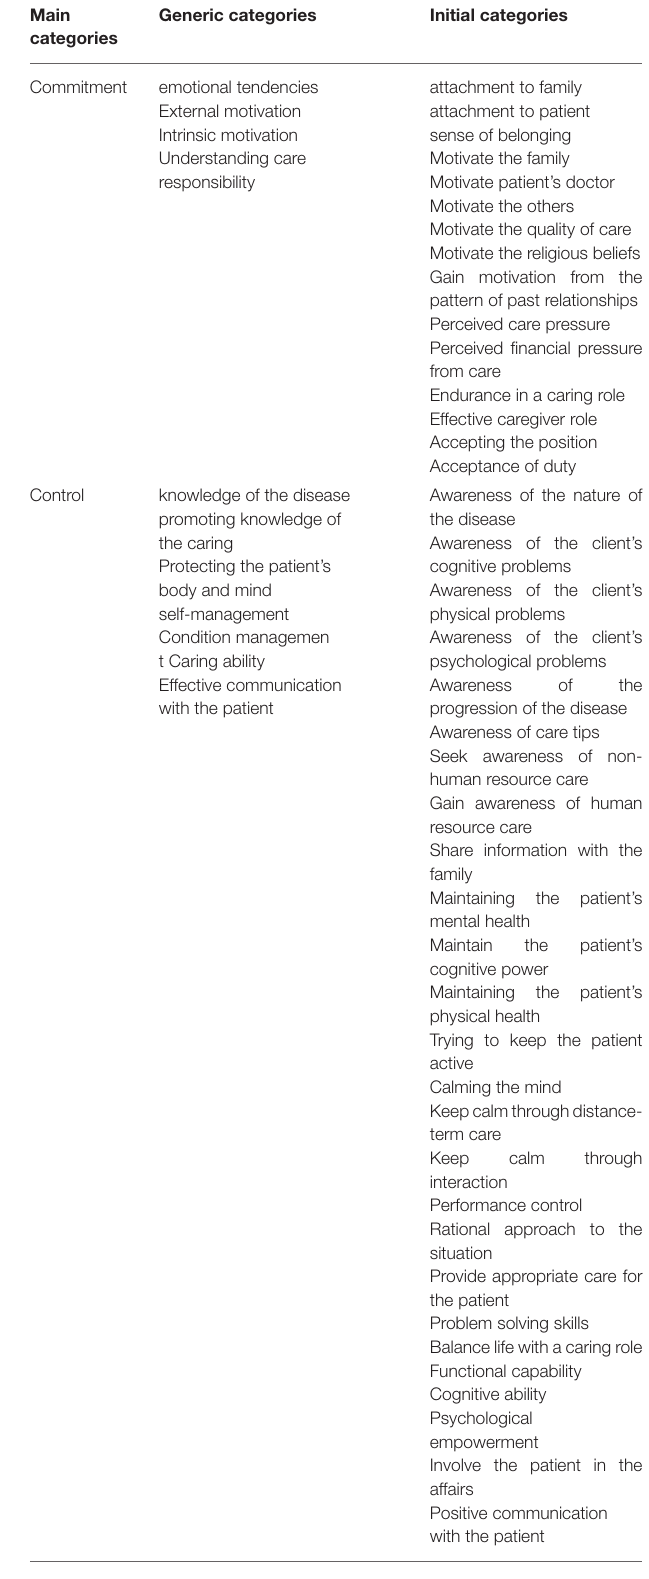
TABLE 3 | Dimensions of hardiness concepts in family